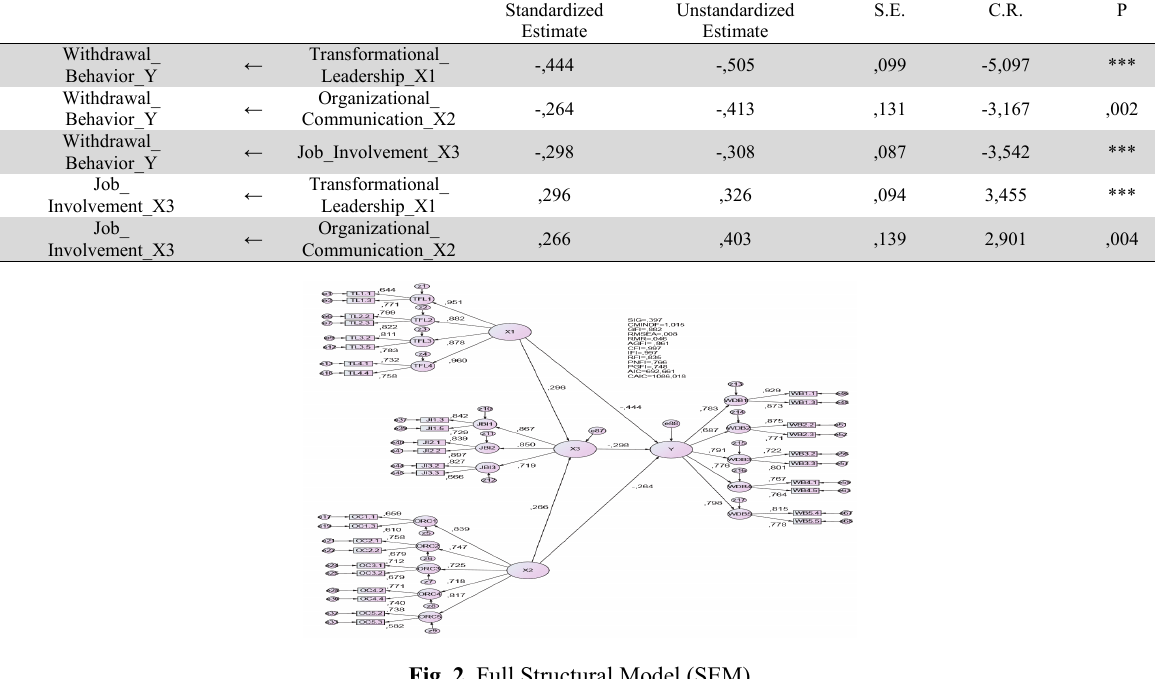
Fig. 2. Full Structural Model